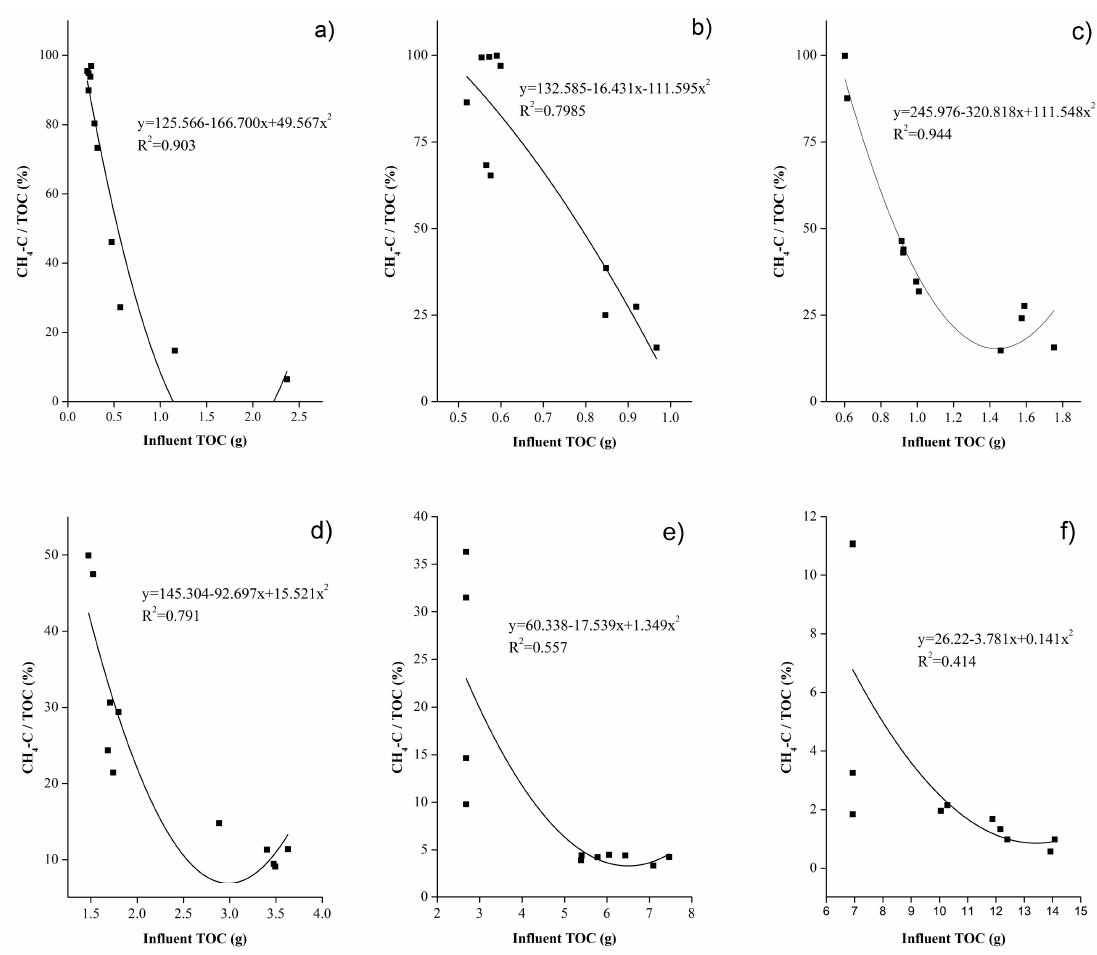
Figure 6. The relationship rate between the CH 4 -C and influent total organic carbon (TOC). ( a ) 0 mmol / L ethanol added; ( b ) 2 mmol / L ethanol added; ( c ) 4 mmol / L ethanol added; ( d ) 8 mmol / L ethanol added; ( e ) 16 mmol / L ethanol added; ( f ) 32mmol / L ethanol added.